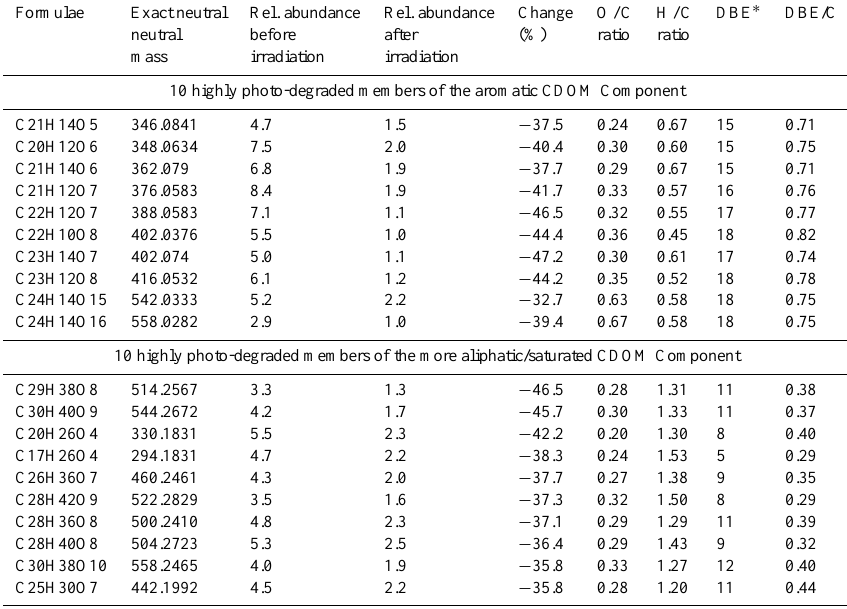
Table 3. The ten most abundant mass peaks and their associated molecular formulae of each of the two distinctly different pools of (1) aromatic and (2) more saturated/aliphatic photosensitive CDOM components analyzed by FT-MS.